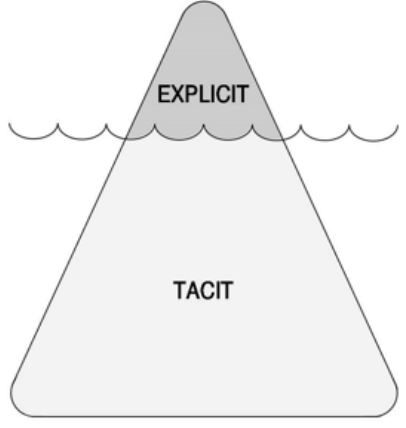
Figure 2. Knowledge as an iceberg.